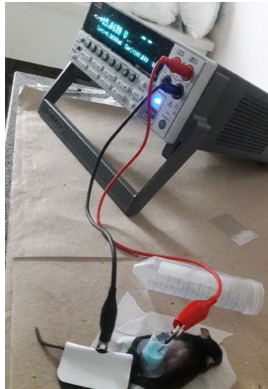
Figure 1. Photograph of the in vivo topical treatment with nanoemulsion iontophoresis application.